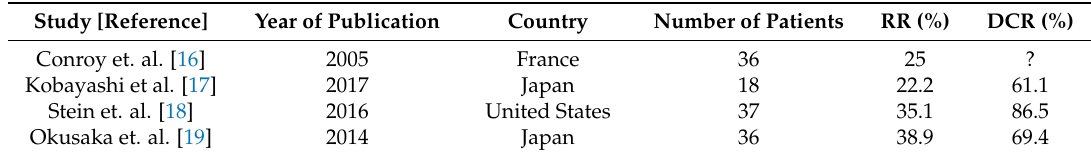
Table 2. Phase II trials pooled in the current meta-analysis of FOLFIRINOX in metastatic pancreatic cancer. The question-mark denotes that the study did not provide the Disease Control Rate (DCR).